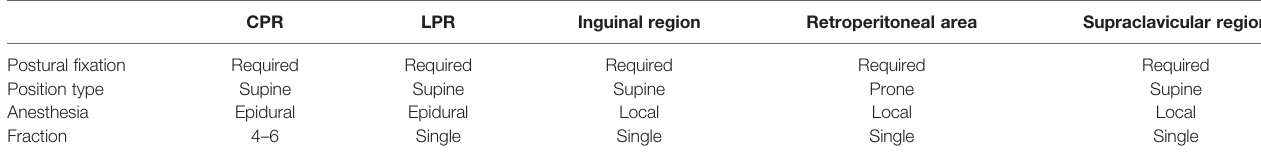
TABLE 4 | Iodine 125 seed implantation for rCC at various